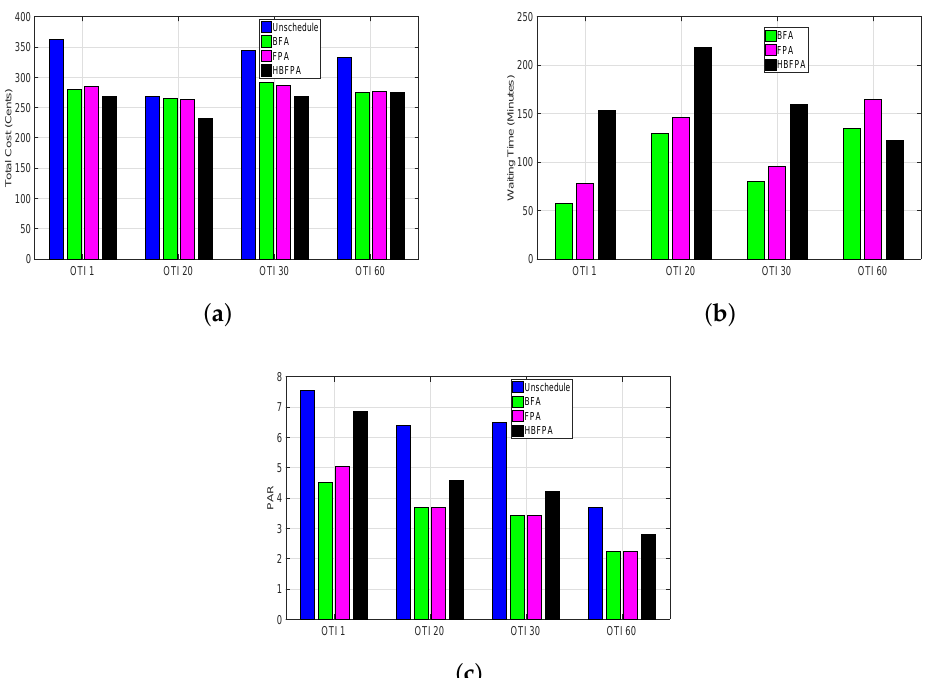
Figure 7. Total cost, waiting time and peak to average ratio for single home using real time pricing. ( a ) Electricity cost using operational time interval of 1, 20, 30, 60 min; ( b ) Waiting time using operational time interval of 1, 20, 30, 60 min; ( c ) Peak to average ratio using operational time interval of 1, 20, 30, 60 min.